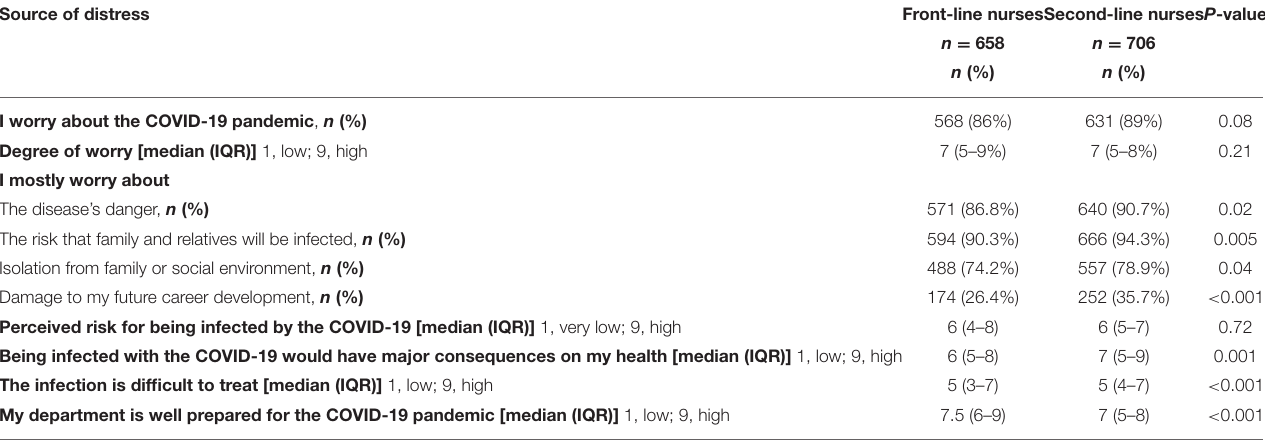
TABLE 3 | Sources of distress reported by 1,364 Chinese nurses during the COVID-19 pandemic. Source of distress